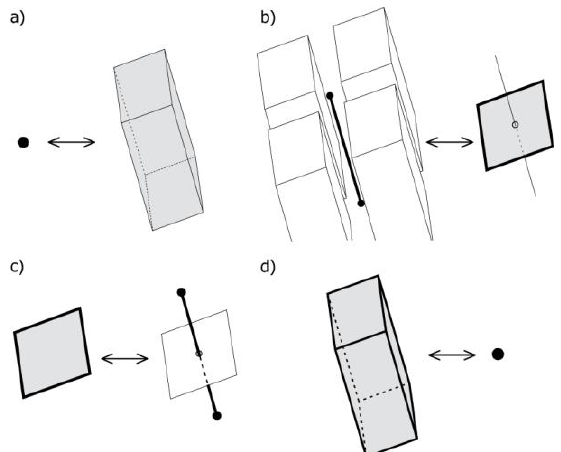
Figure 2. Poincaré duality. Figure 2. 3D Poincaré duality: ( a ) primal vertex corresponds to a dual cell (volume); ( b ) primal edge corresponds to a dual face; ( c ) primal face corresponds to a dual edge; ( d ) primal cell corresponds to a dual